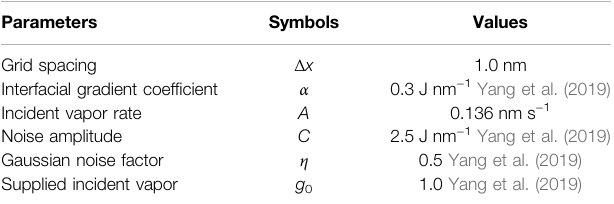
TABLE 1 | List of numerical/material parameters used in the present phase- fi eld simulations.